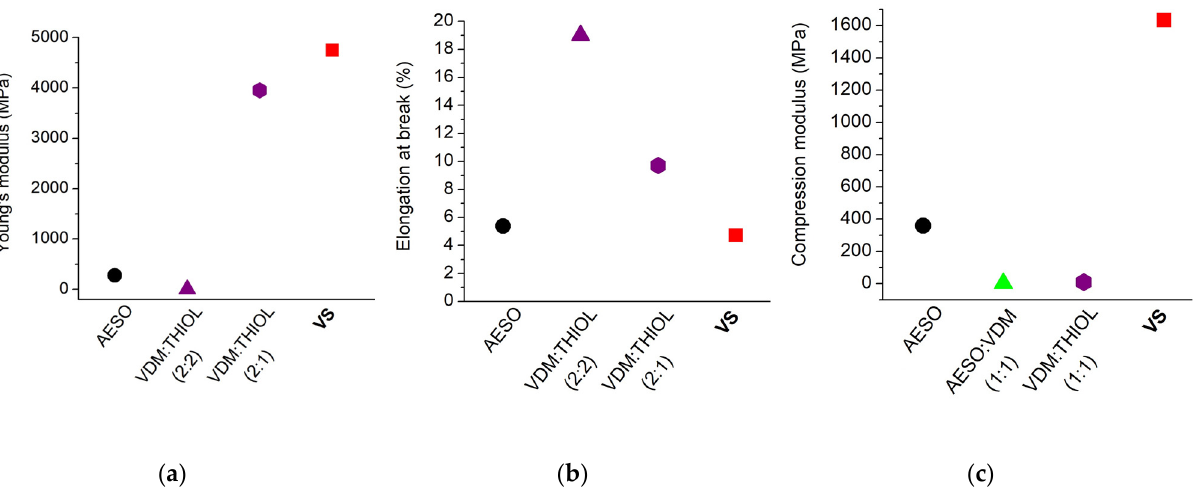
Figure 6. Comparison of Young’s modulus ( a ), elongation at break ( b ), and compression modulus ( c ) of the polymer VS and the polymers of AESO [33], AESO and VDM [40], VDM and THIOL [15,39]. The molar ratio of the monomers is presented in parentheses.